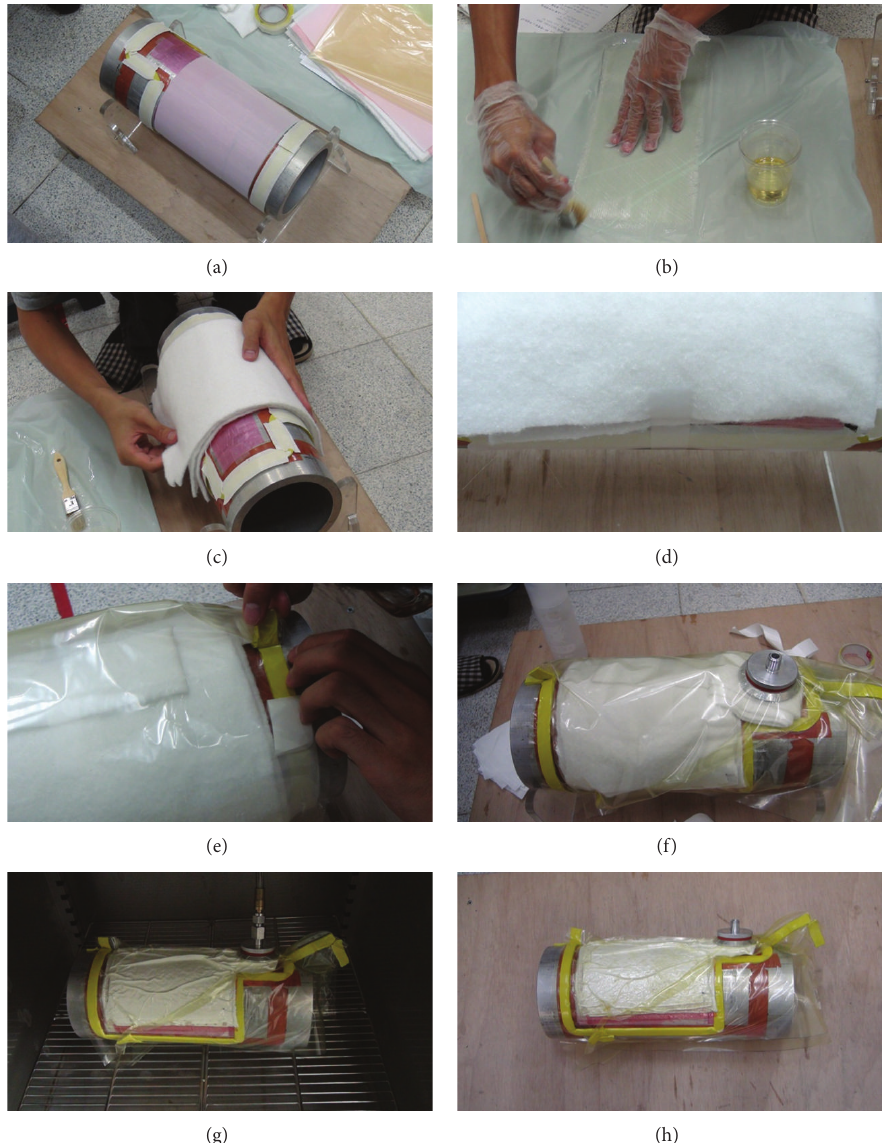
Figure 6: Photos of the fabrication process for the fiberglass